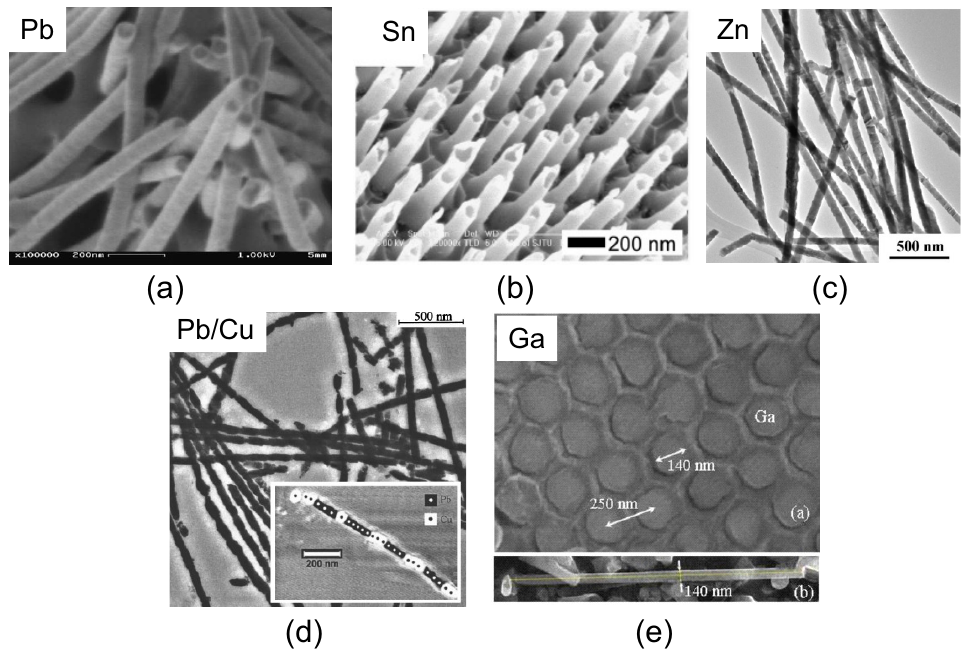
Figure 3. SEM micrographs of various superconducting nanowires of conventional metallic supercon- ductors ( a ) Pb, ( b ) Sn, ( c ) Zn, ( d ) Pb/Cu, and ( e ) Ga. The insets to ( d , e ) give details of an individual nanowire; ( a , b ) are reprinted with permission from Elsevier [8,52–54], ( c ) is Reprinted (Adapted) with permission from Ref. [38]. Copyright 2005 American Chemical Society, ( d ) is Reprinted with permission from Ref. [54] Copyright 2005 AIP Publishing, and ( e ) is reprinted with permission from Ref. [8]. Copyright 2017 Springer